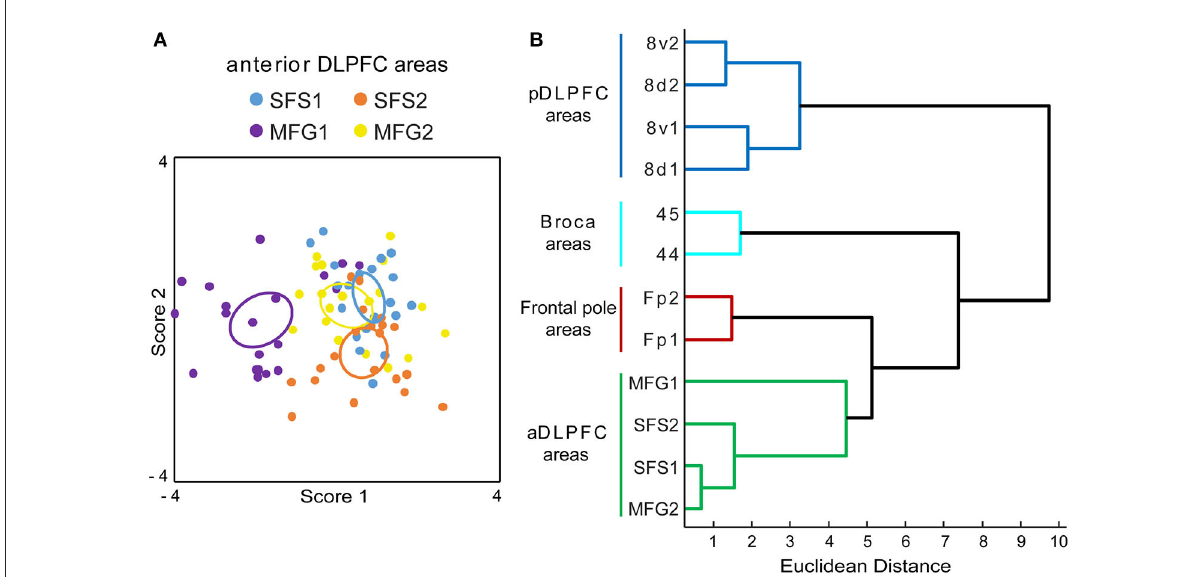
FIGURE9 Discriminant and cluster analysis of Gray Level Index (GLI) profiles. The GLI profiles of all anterior dorsolateral prefrontal cortex (aDLPFC) areas were compared in a discriminant analysis (A) . Each area is represented by a set of 20 dots (2 hemispheres of 10 brains) and an ellipsoid, indicating the centroid for each area. The variance in the localization of the dots reflects the cytoarchitectonic intersubject variability. Area MFG1 (purple) and area SFS2 (orange) can be separated from the areas SFS1 (blue) and MFG2 (yellow). The dendrogram of the hierarchical cluster analysis (B) separates the aDLPFC areas from the frontal pole areas Fp1 and Fp2 (Bludau et al., 2014), Broca areas 44 and 45 (Amunts et al., 2004), and areas of the posterior DLPFC (pDLPFC) 8v1, 8v2, 8d1, and 8d2 (Amunts et al., 2021). aDLPFC areas form a distinguishable separate cluster, representing structural differences compared to their adjacent areas in the prefrontal cortex. A high Euclidean distance on the x-axis indicates structural